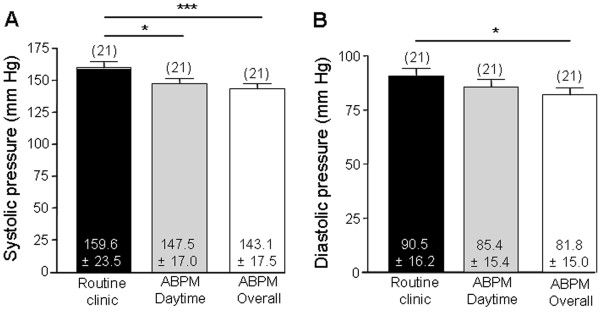
Comparison between routine clinic readings and ambulatory BP. A. Bar graph comparing routine clinic systolic BP with the daytime and overall mean systolic readings obtained through ABPM. ANOVA (repeated measures) showed a significant overall difference (P < 0.0001). Bonferroni’s multiple comparisons post hoc tests showed that the routine clinic systolic reading was significantly higher than the ABPM daytime (P < 0.05) and ABPM overall (P < 0.001) systolic readings. B. Bar graph comparing routine clinic diastolic BP with the daytime and overall mean diastolic readings obtained through ABPM. ANOVA (repeated measures) showed a significant overall difference (P < 0.0001). Bonferroni’s multiple comparisons post hoc tests showed that the routine clinic diastolic reading was significantly higher than ABPM overall diastolic reading (P < 0.05).